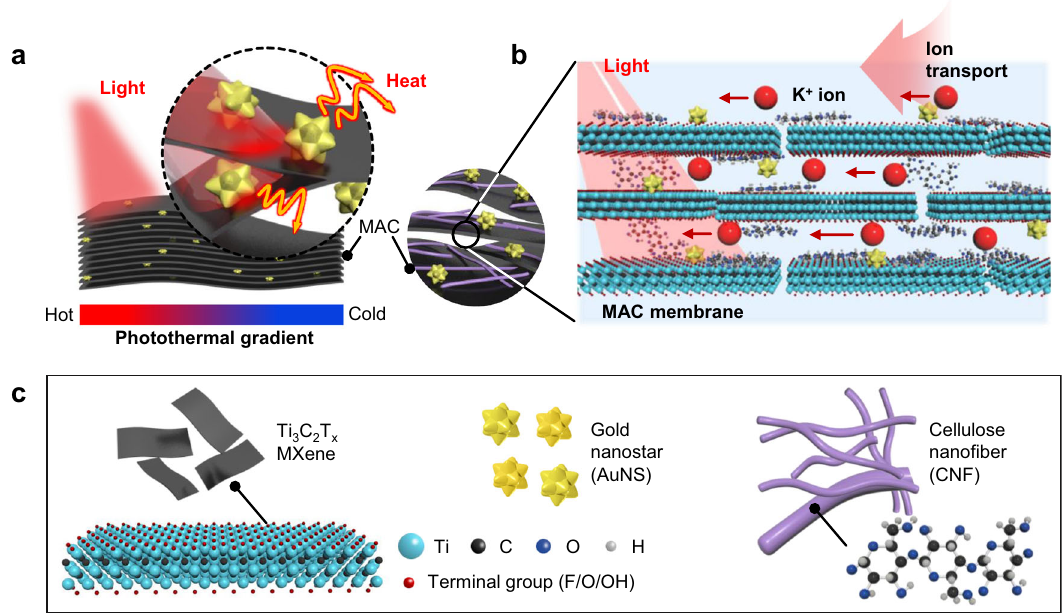
Fig. 1 | Schematic illustration of photosensitive MXene/AuNS/CNF (MAC) membrane. a MAC membrane under exposure to localized NIR light. The plas- monicAuNSsandMXenenanosheetsenhancethephotothermaleffectofthe MAC membranetogeneratephotothermalgradientacrossthemembrane. b Directional